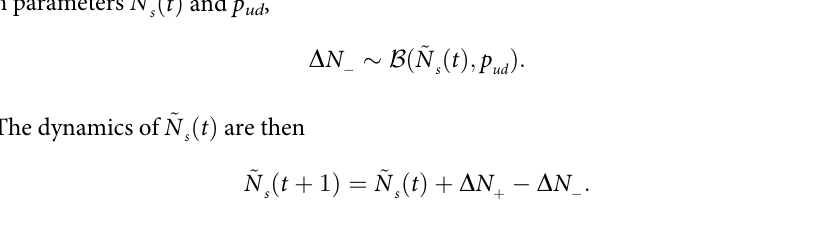
Fig 3. The double-sigmoid performance function, Eq 6. In all cases, n 50 = 20, s curve). The consequence of increasing n 0